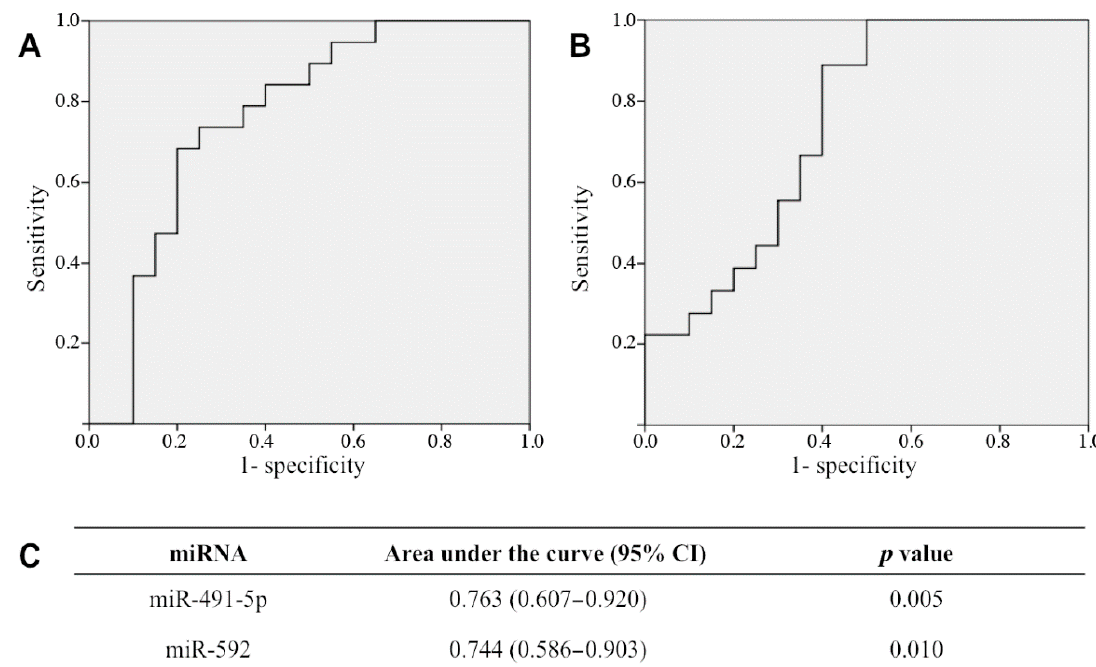
Figure 2. ROC curves for miR-491-5p ( A ) and miR-592 ( B ) were generated from the control (n = 20) and OAB (n = 20) groups. The values for the area under curve (AUC) with a 95% confidence interval (CI) for significant miRNAs are shown in table ( C ).